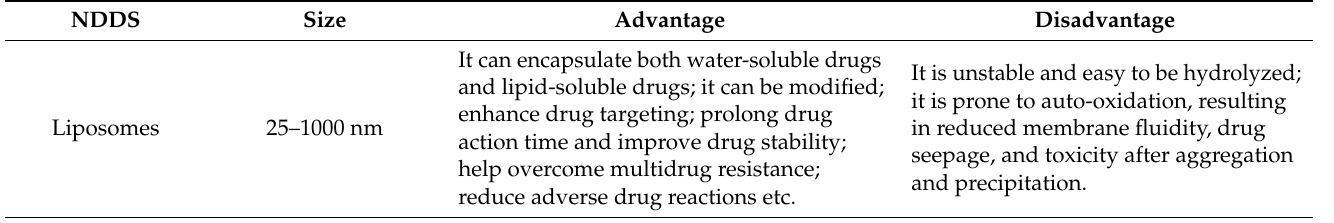
Table 1. A brief summary of several